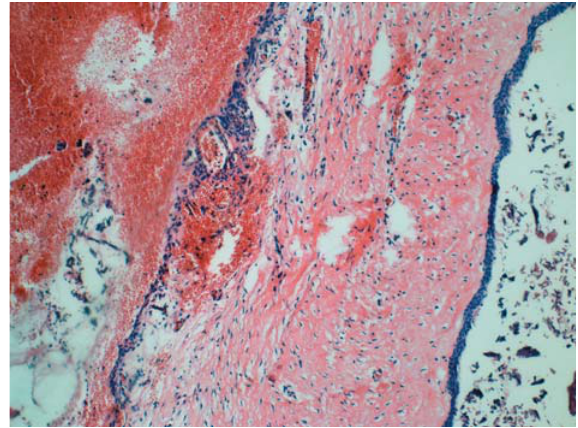
Figure 1- Photomicrograph of the lesion showing the cystic lesion lined by non-keratinized epithelium and hemorrhagic areas (hematoxylin and eosin, original (cid:2)(cid:3)(cid:4)(cid:5)(cid:6)(cid:7)(cid:8)(cid:3)(cid:9)(cid:6)(cid:10)(cid:5)(cid:11)(cid:12)(cid:13)(cid:14)(cid:14)(cid:15)